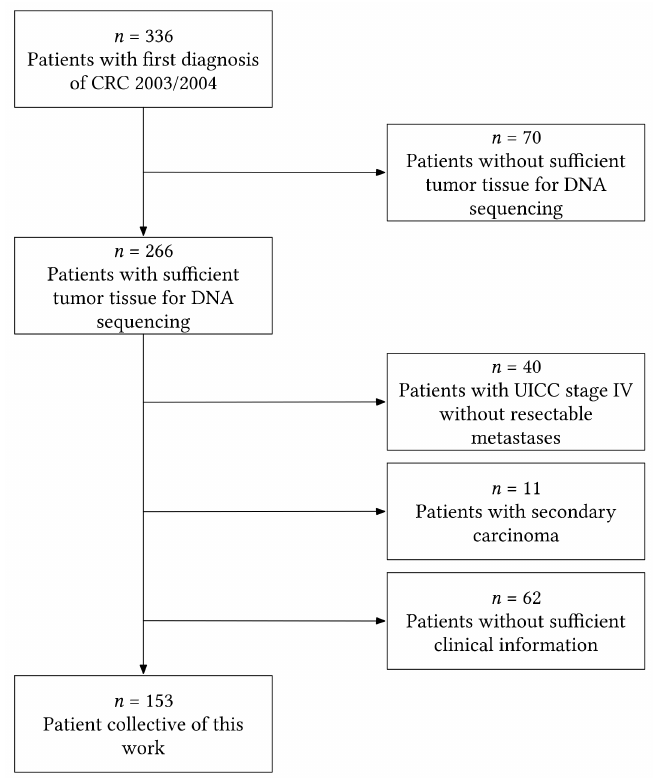
Figure 1. Flowchart illustrating patient-exclusion criteria leading to the final study cohort of 153 pa- tients. CRC = colorectal